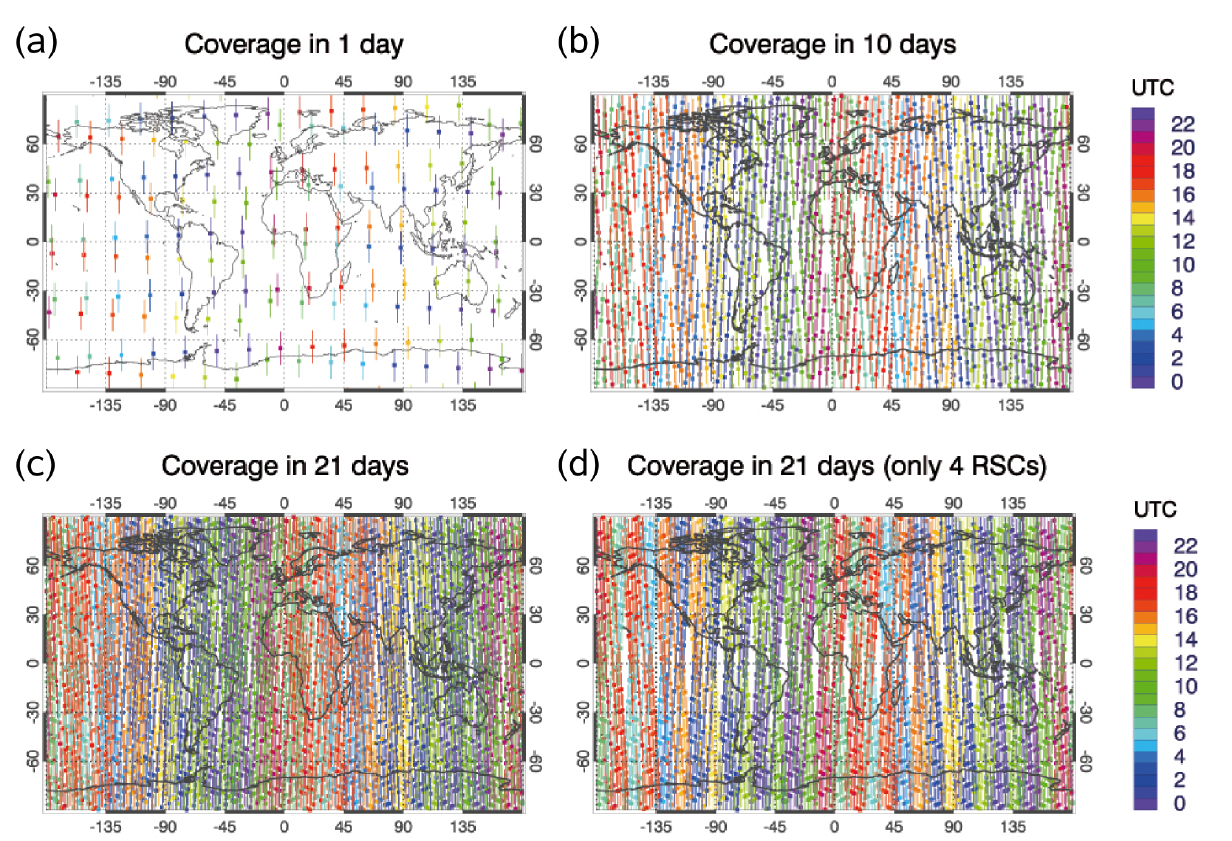
Figure 3. Ground tracks of collocated nadir and limb measurements from a configuration using five retroreflectors, coloured by time of day UTC, for ( a ) one day, ( b ) ten days, ( c ) 21 days and ( d ) 21 days, with only four